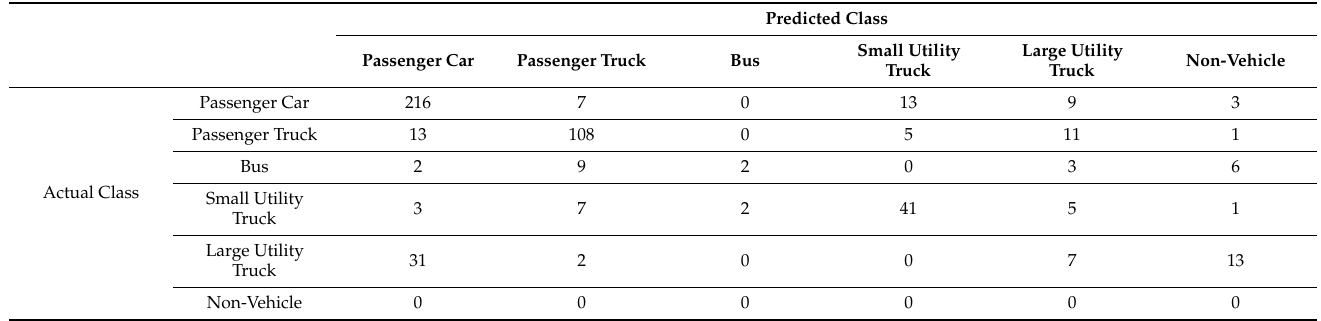
Table 20. Confusion matrix for multiple vehicle cluster detections for Video 4.